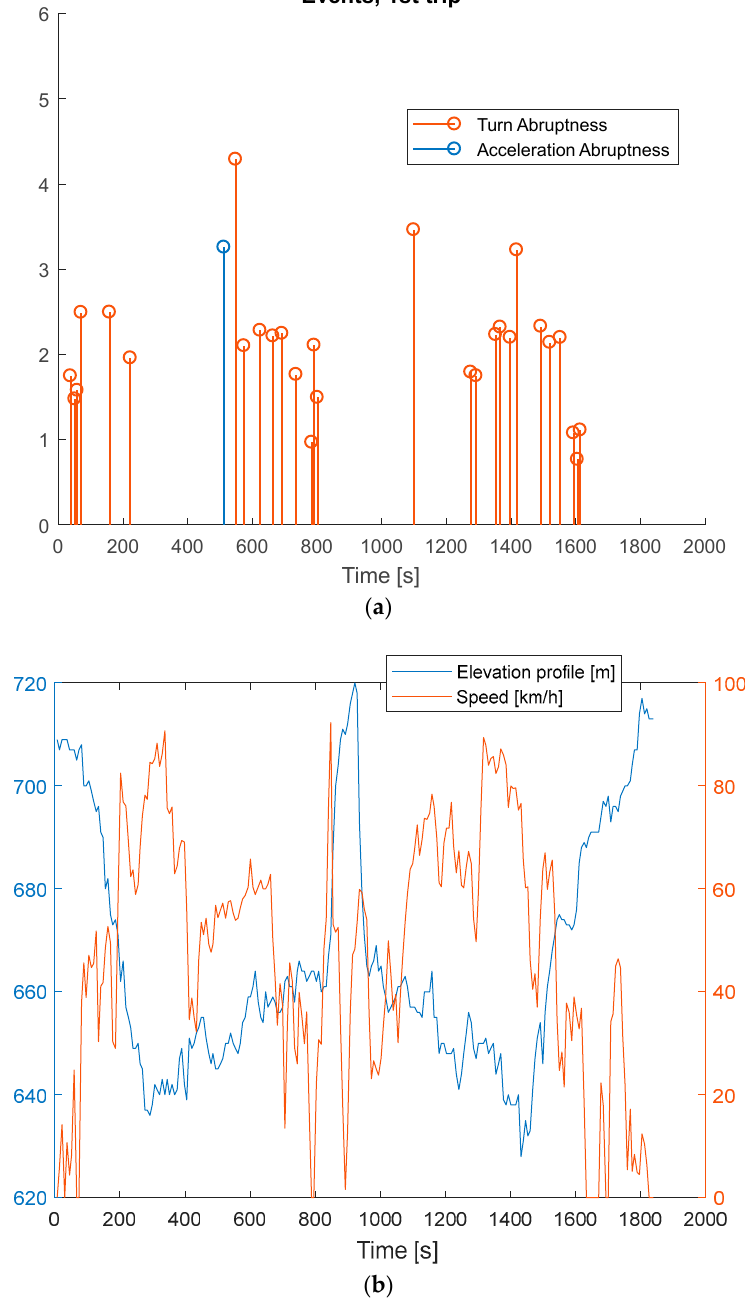
Figure 10. ( a ) Detected events during Trip #1 ( b ) Speed and elevation profiles during Trip #1.